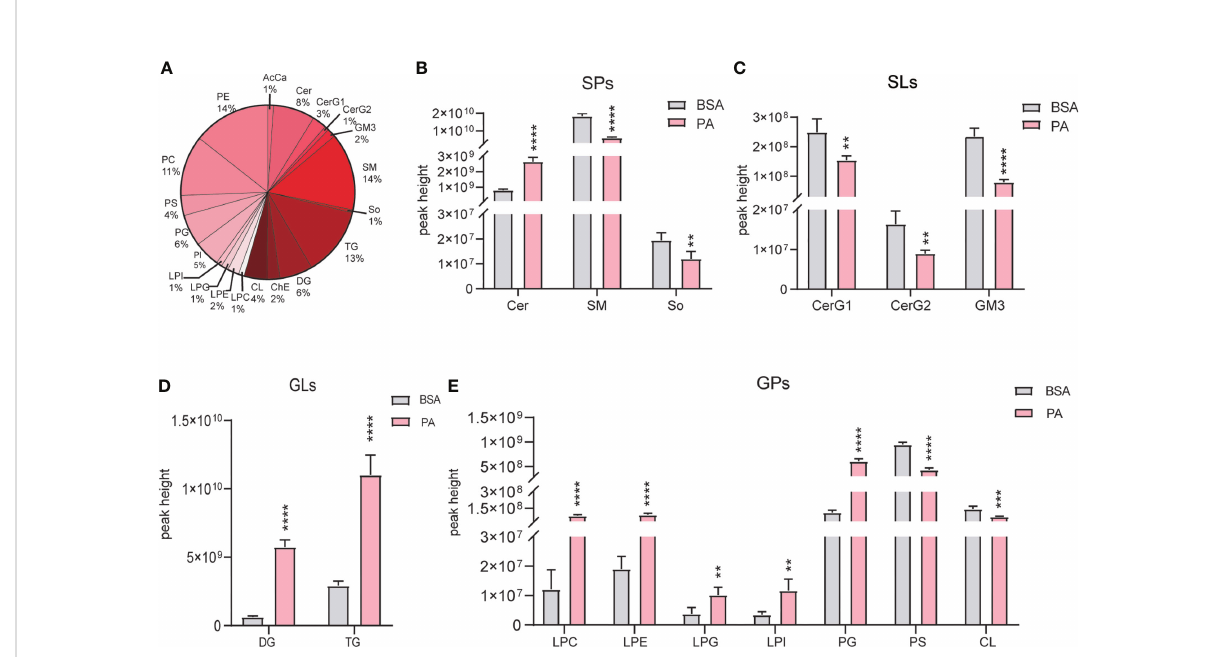
FIGURE 5 Overall lipid pro fi les of SCs treated with PA and BSA. (A) Percentage of lipid subclasses detected in SCs. The peak height of GLs (B) , SPs (C) , GLs (D) , and GPs (E) in the PA group and BSA group. Data were expressed as mean ± SD, **p < 0.01, ***p < 0.001, ****p <